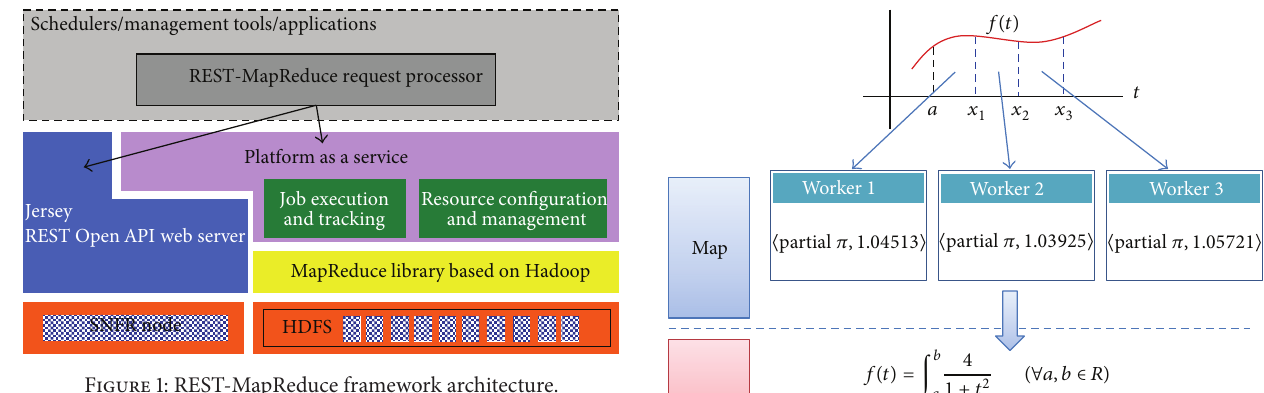
Figure 1: REST-MapReduce framework architecture.